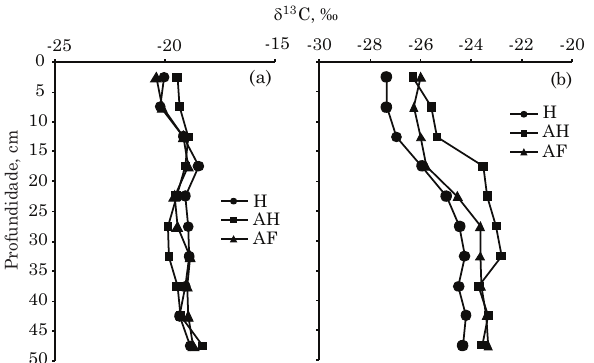
Figura 3. Valores médios de δδδδδ 13 C (‰) da humina (H), ácidos húmicos (AH) e ácidos fúlvicos (AF), em profundidade no Organossolo sob: (a) Campo Limpo Úmido (CLU); e (b) Floresta Estacional Semidecidual (FES).